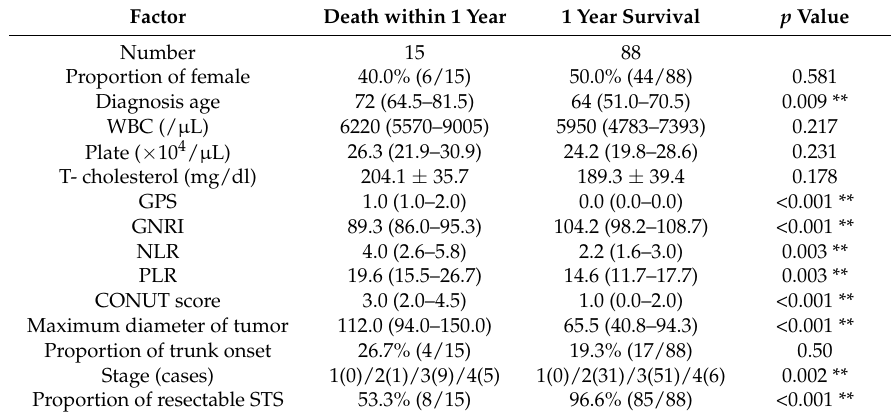
Table 2. Difference of variables between patients who died within one year and patients who lived longer.